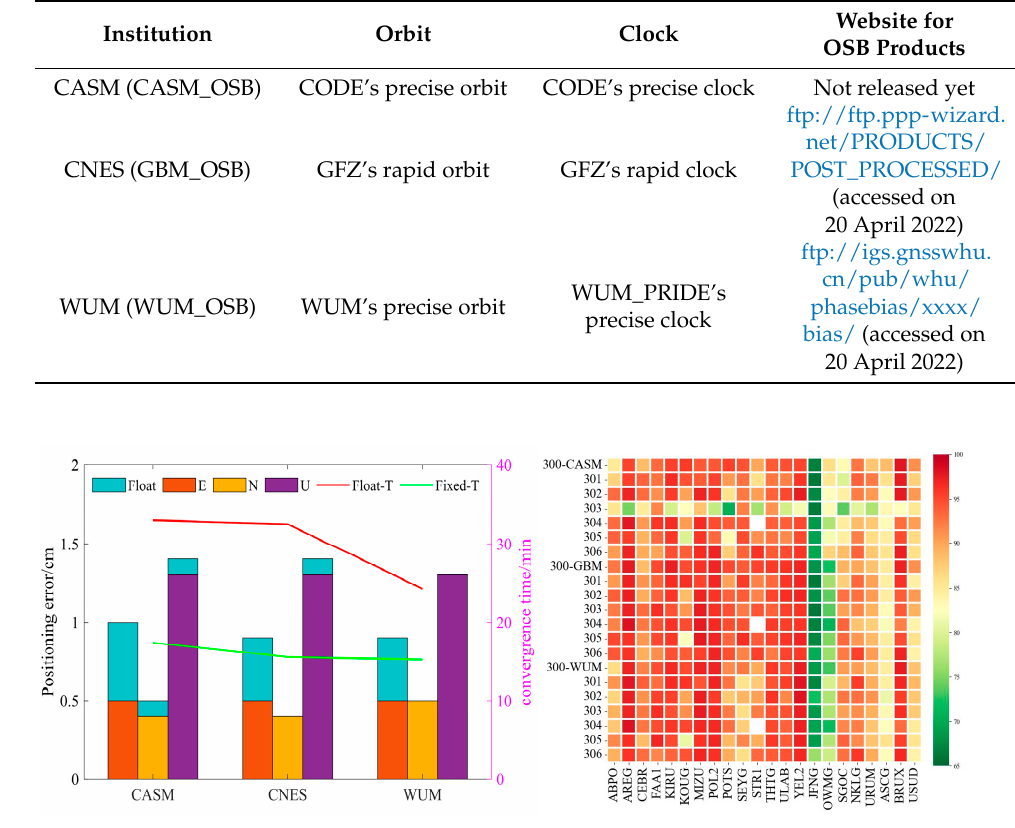
Figure 8. The GPS static RMS of positioning error, convergence time ( left ), and fixed-ambiguity success rate ( right ) on DOY 300–306, 2021, for 22 stations of the IF model for the CASM_OSB, GBM_OSB, and WUM_OSB products.